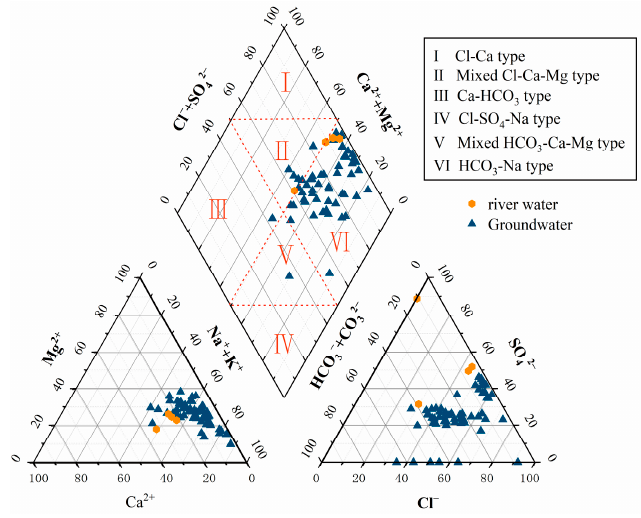
Figure 6. Piper diagram of groundwater chemical composition in the study area.